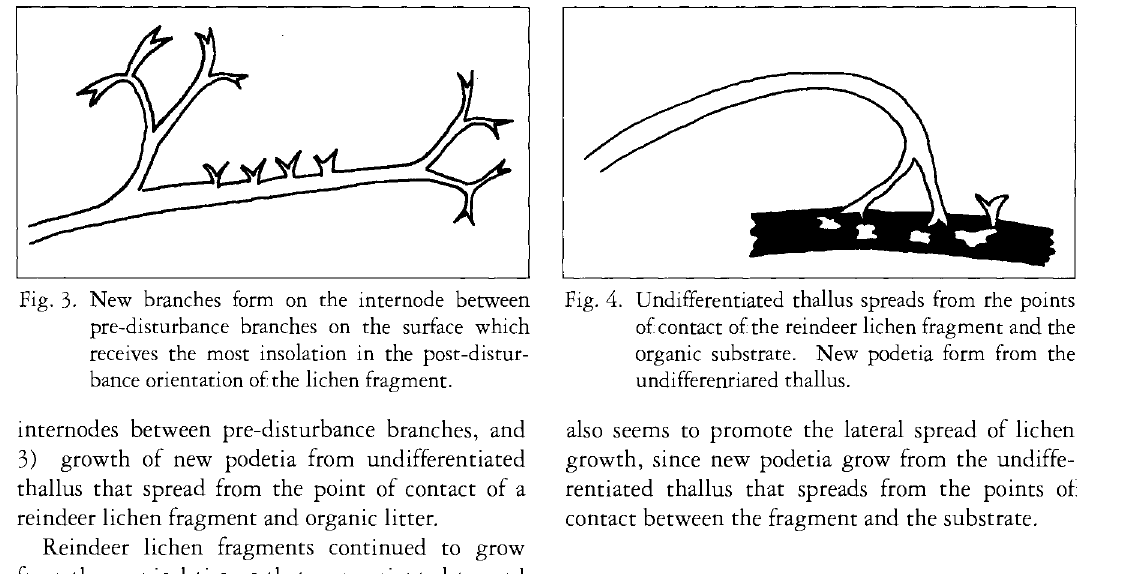
Fig. 3. New branches form on the internode between pre-disturbance branches on the surface which receives the most insolation in the post-distur bance orientation of the lichen fragment.